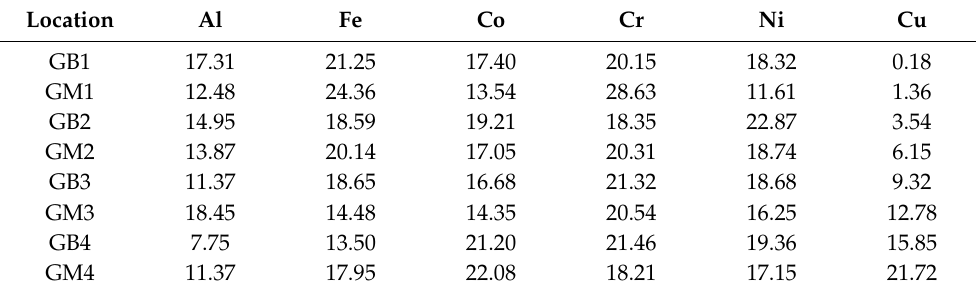
Table 5. EDS analysis of zone GB1-GM4, GB1-GB4 in Figure 3 at %. Location